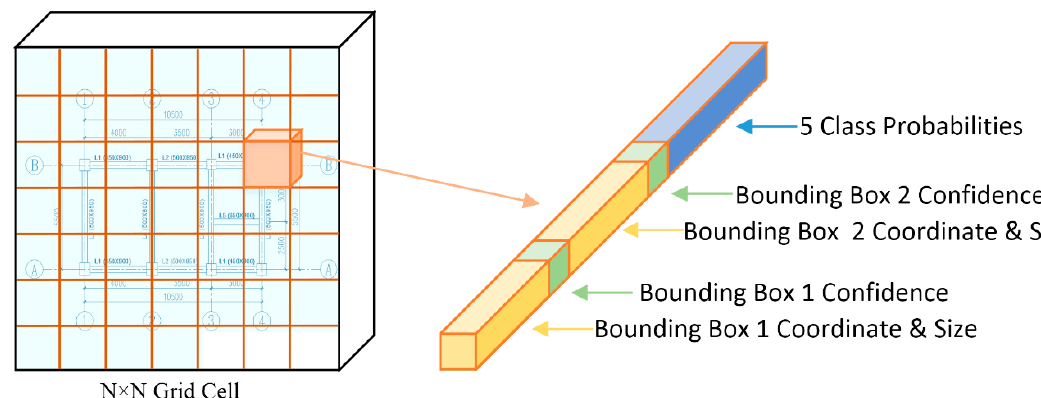
Figure 3. The prediction information contained in each grid cell.